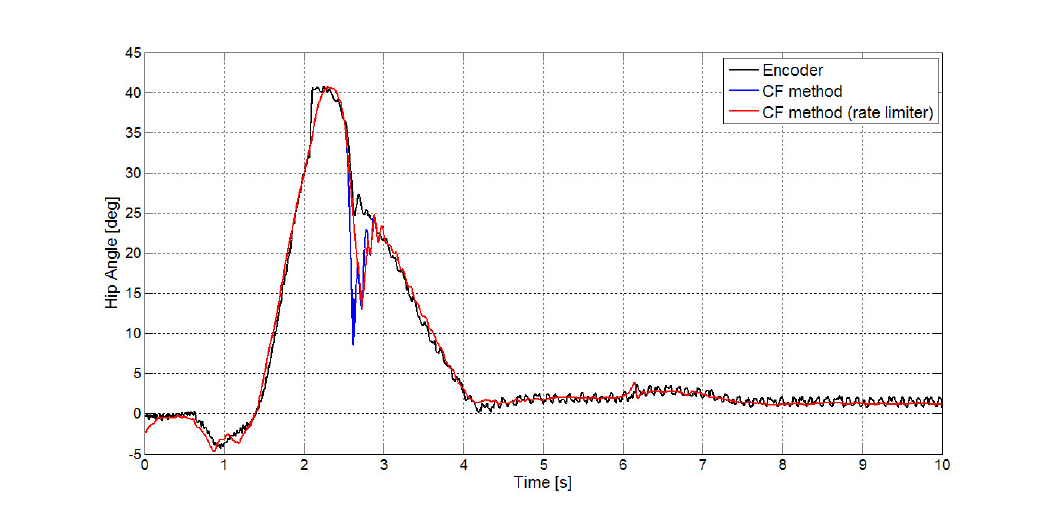
Figure 7. Estimation of the angles by means of the CF method vs. encoder measurement: ( a ) hip angle; ( b ) particulars of the hip angle estimation; ( c ) knee angle; ( d ) particulars of the knee angle estimation.